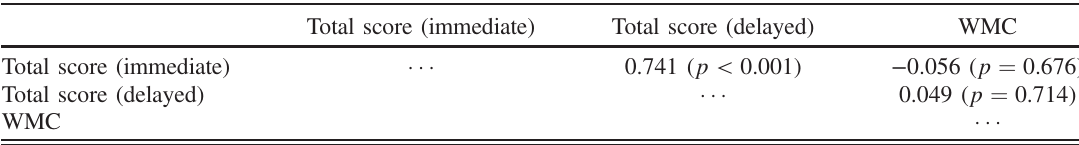
TABLE II. Correlation matrix for the total scores of the two final tests and working memory capacity.